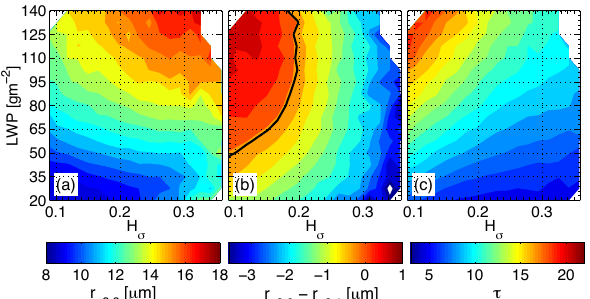
Fig. 3: Binned values for cloudy scenes (CF > 98%) as a function of H σ and AMSR-E 490 Fig. 3. Binned values for cloudy scenes (CF > 98%) as a function of H σ and AMSR-E LWP: (a) r e 3 . 8 , (b) 1 r e = r e 3 . 8 – r e 2 . 1 , with zero LWP: a) r e3.8 , b) Δ r e =r e3.8 -r e2.1 , with zero values denoted by the black contour, and c) τ . 491 values denoted by the black contour, and (c) τ . The bin sizes are The bin sizes are 0.016 and 7.5 gm -2 for CF and H σ , respectively. Bins constructed with 492 0.016 and 7.5gm − 2 for CF and H σ , respectively. Bins constructed less than 30 samples were excluded. 493 with less than 30 samples were excluded.